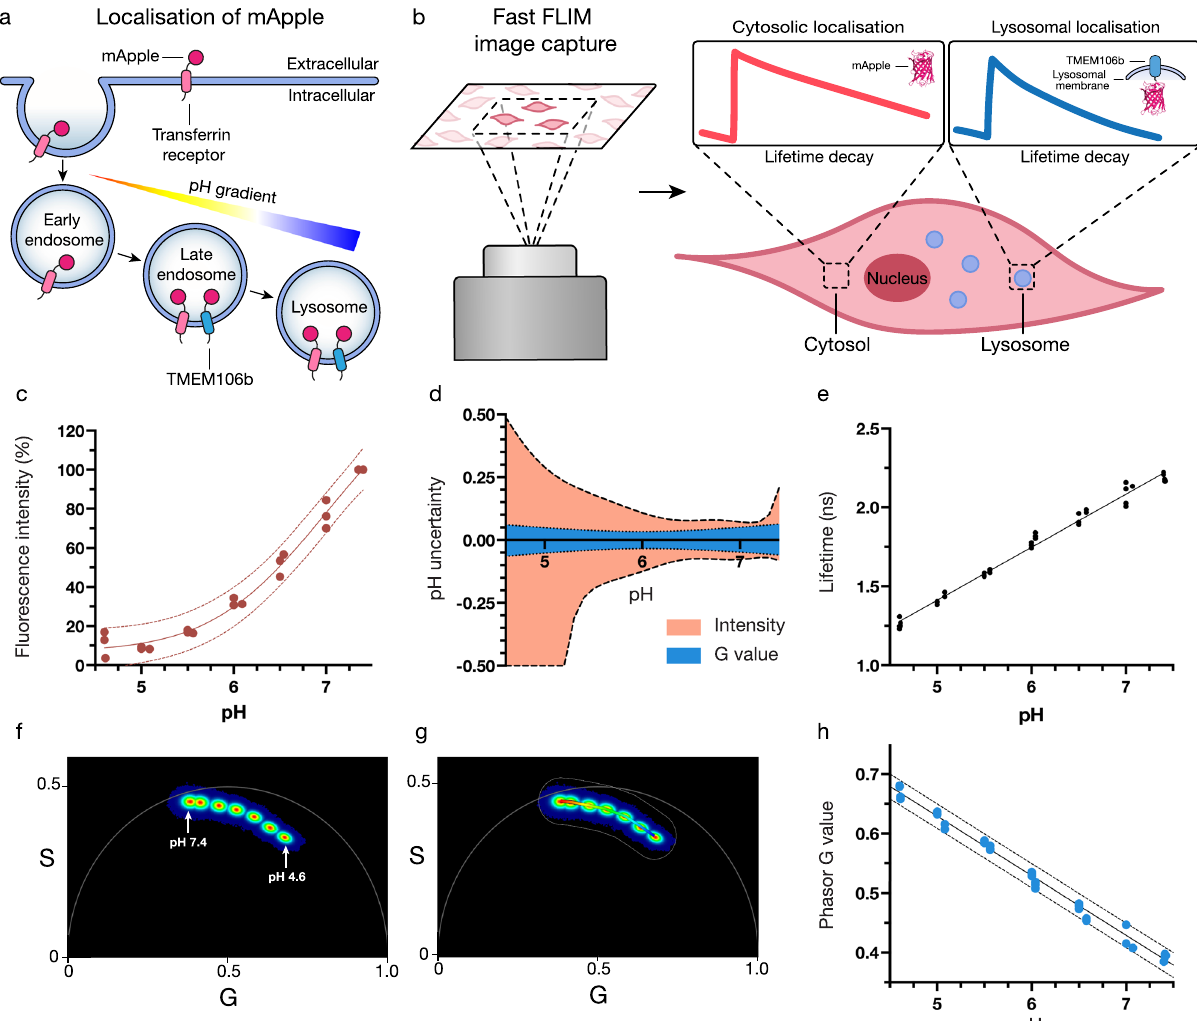
Fig. 1 | mApple is a genetically encodable biosensor that can quantitatively determinesubcellularpHusingfastFLIM.a Schematicofcellularmembraneand endocytic vesicles with mApple fused to different transmembrane proteins to achievetargetedcellularlocalisation.pHgradientindicatesincreasingacidi fi cation as endosomes mature. Not to scale. b Overview of FLIM technique involving con- focal microscopy of mApple expressing cells and subsequent analysis indicating the alteredmApple fl uorescencelifetime indifferentsubcellular pH environments. c mApple fl uorescence emission intensity over the calibration range with the least squares fi t(solidline)and95%predictionband(dottedlines).Thepointsshownare the meanvalue from each of three independentexperiments ( n =3). d Uncertainty